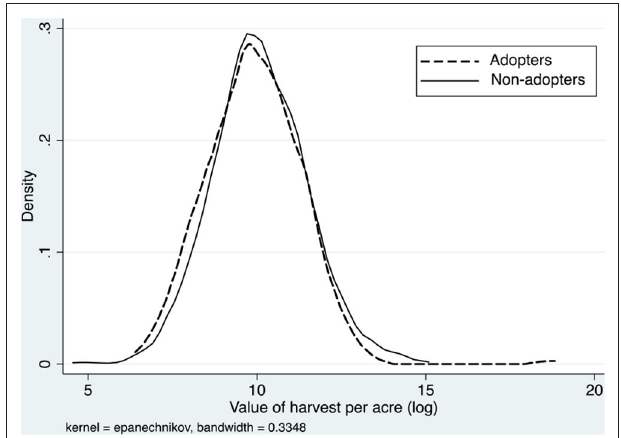
FIGURE 1 | Kernel density distribution of the log of value of harvest per acre for adopters and non-adopters of organic fertilizers.